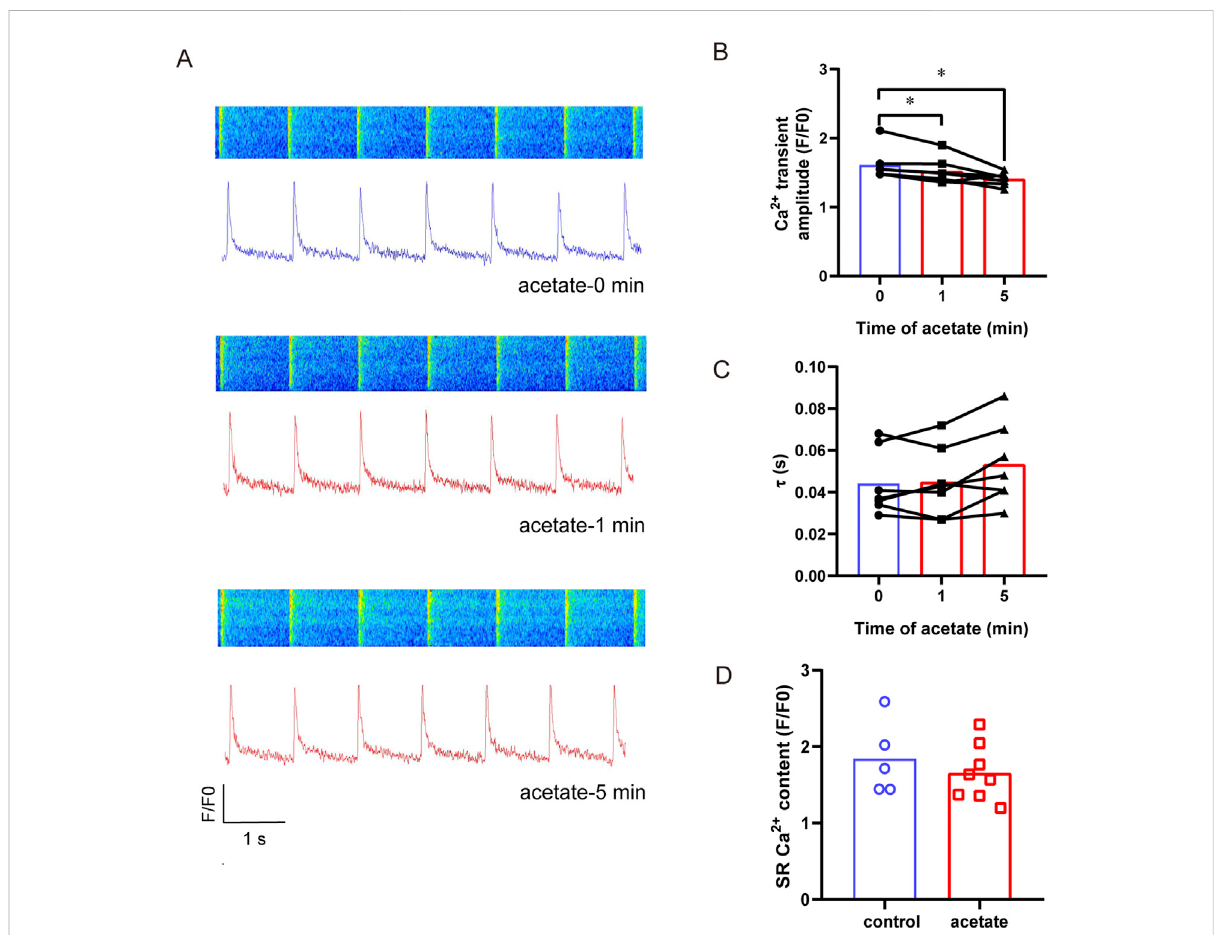
FIGURE 4 Acetate decreased the amplitude of calcium transient in rat cardiomyocytes. Original plot of calcium transient in isolated myocardial cell (A) . The calcium transient amplitude (B) and calcium recovery rate (C) , N = 5, n = 7. The Ca 2+ content of sarcoplasmic reticulum in cardiomyocytes (D) , N = 5 for each group, n = 5 for control group, n = 8 for acetate group. N: the number of rats, n: the number of cells. * p <